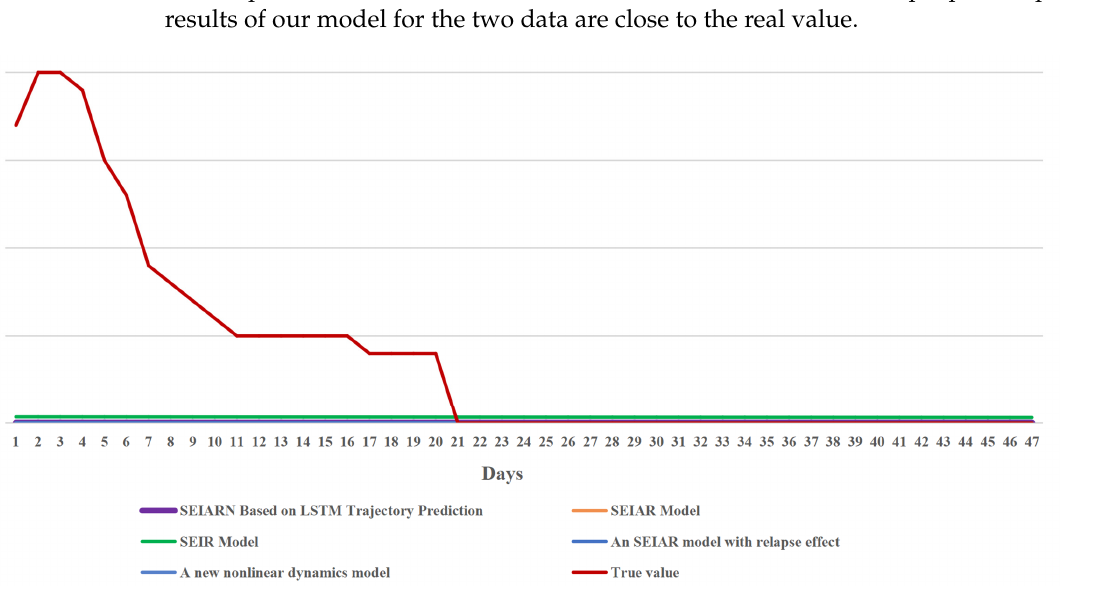
Figure 19. Comparison chart of the number of infected people.